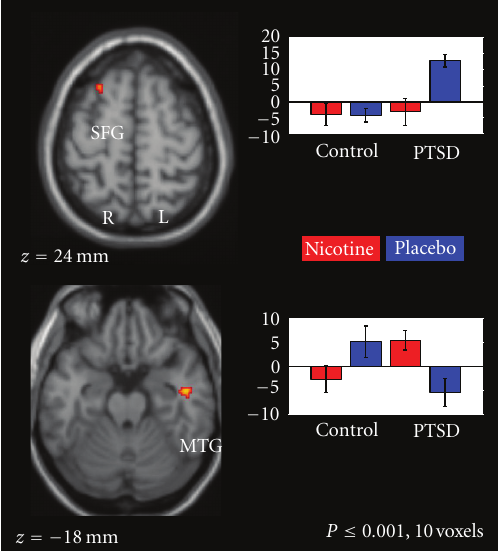
Figure 4: fMRI contrast of the patch x group interactions. Significant patch x group interactions were observed in right superior frontal gyrus (SFG) ( x = 24, y = 22, z = 60) and left middle temporal gyrus (MTG) ( x = − 48, y = − 10, z = − 24).